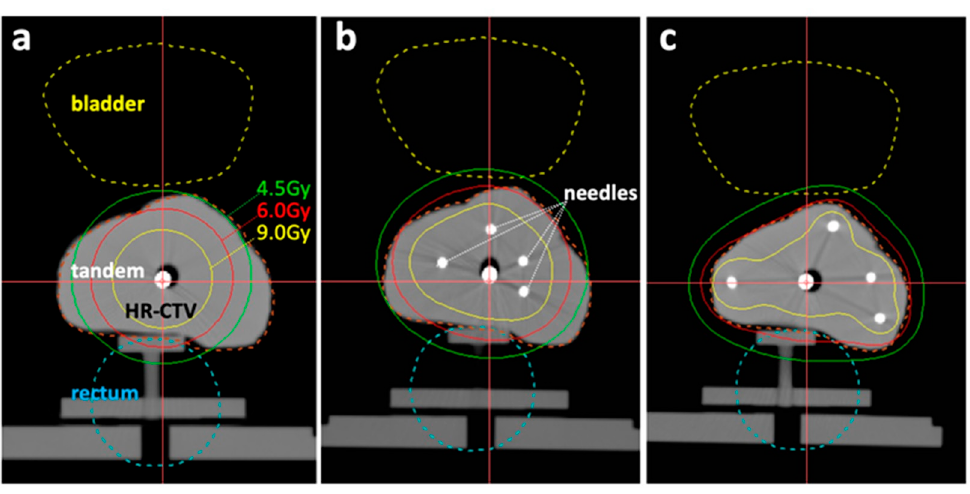
Figure 3. Representative dose-distributions for the treatment plans in the trial use of the IC/IS train- ing simulator with: ( a ) Fletcher-Suit Asian Pacific applicator inserted by an expert; ( b ) Fletcher-Suit Asian Pacific applicator and interstitial needles inserted by the resident; ( c ) Fletcher-Suit Asian Pa- cific applicator and interstitial needles inserted by an expert; ( d ) Venezia applicator inserted by an expert; ( e ) Venezia applicator and interstitial needles inserted by the resident; or ( f ) Venezia appli- cator and interstitial needles inserted by expert. 4. Discussion Despite its efficacy, multiple reports suggest that the use of brachytherapy in cervical cancer treatment has been diminishing in recent decades. In 2013, Han et al. reported a decrease in the brachytherapy utilization rate from 83% in 1988 to 58% in 2009, using data from the National Cancer Institute’s Surveillance, Epidemiology, and End Results pro- gram covering 7359 patients with stage IB2 to IVA cervical cancer who were treated with EBRT [20]. In their study, the use of brachytherapy was independently associated with better cause-specific and overall survival. More recently, Robin et al. reported that less than 50% of cervical cancer patients diagnosed between 2004 and 2012 received a standard of care including EBRT and brachytherapy according to the National Cancer Database [21]. More importantly, the number of brachytherapies performed by residents decreased over the period 2006–2007 to 2010–2011 according to the Accreditation Council of Gradu- ate Medical Education final resident case logs, where the number of interstitial procedures decreased by 25% over the period [22]. These data highlight an increasing need for the education and training of IC/IS brachytherapy, especially for early-career physicians.